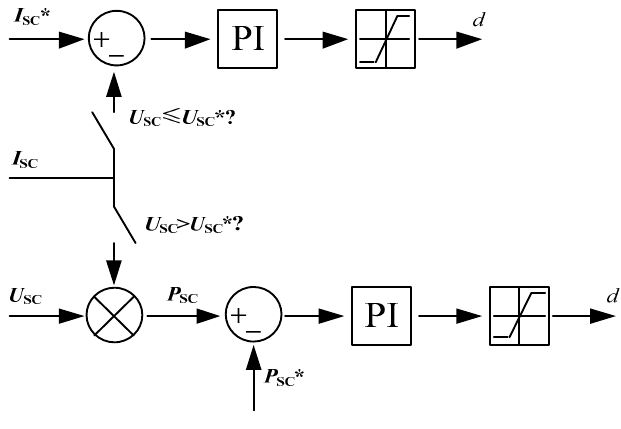
Figure 12. Charging strategy for supercapacitor.